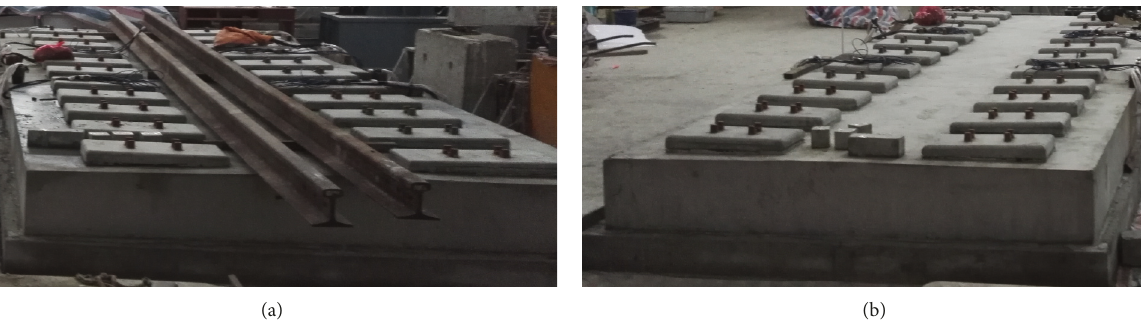
Figure 4: Full-scale model physical maps: (a) N-LVT and (b) T-LVT.